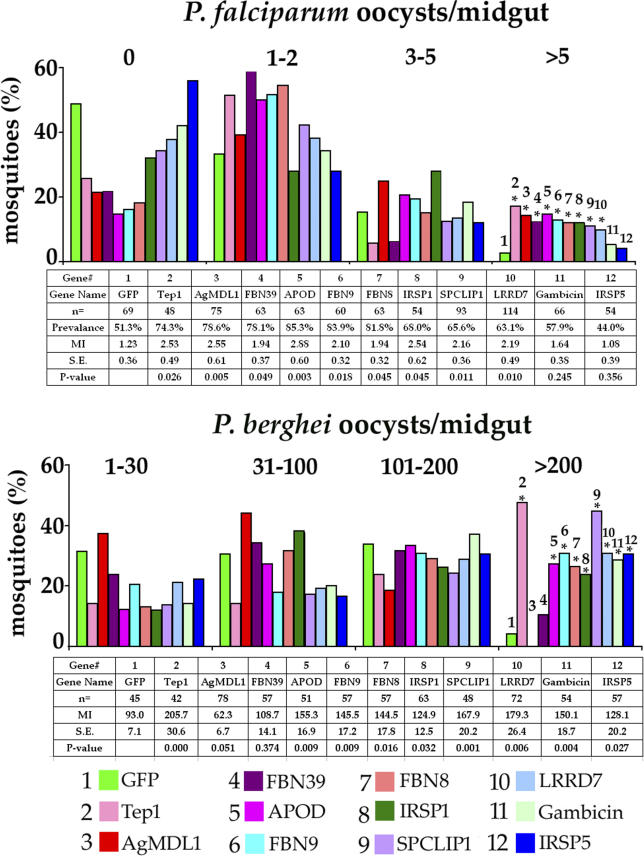
Effects of Gene Silencing of 11 Selected Putative Immune Genes on P. falciparum and P. berghei InfectionThe gene silencing efficiency values (KD %) are displayed in Table S6. The frequency distribution of oocysts pooled from three independent assays is displayed, with bars indicating the percentile of mosquitoes with the corresponding oocyst number in the range indicated on the x-axis. Equal numbers of midguts from all three experiments in each dataset were pooled. Bars with asterisks indicate the statistically significant differences at the 95% confidence level, based on the p value from two independent probability tests, the KS and Mann-Whitney tests (Tables S5 and S6). n: total midguts assayed; MI: mean intensity of infection (oocysts number); S.E.: standard error of mean intensity; p value: from Mann-Whitney test.